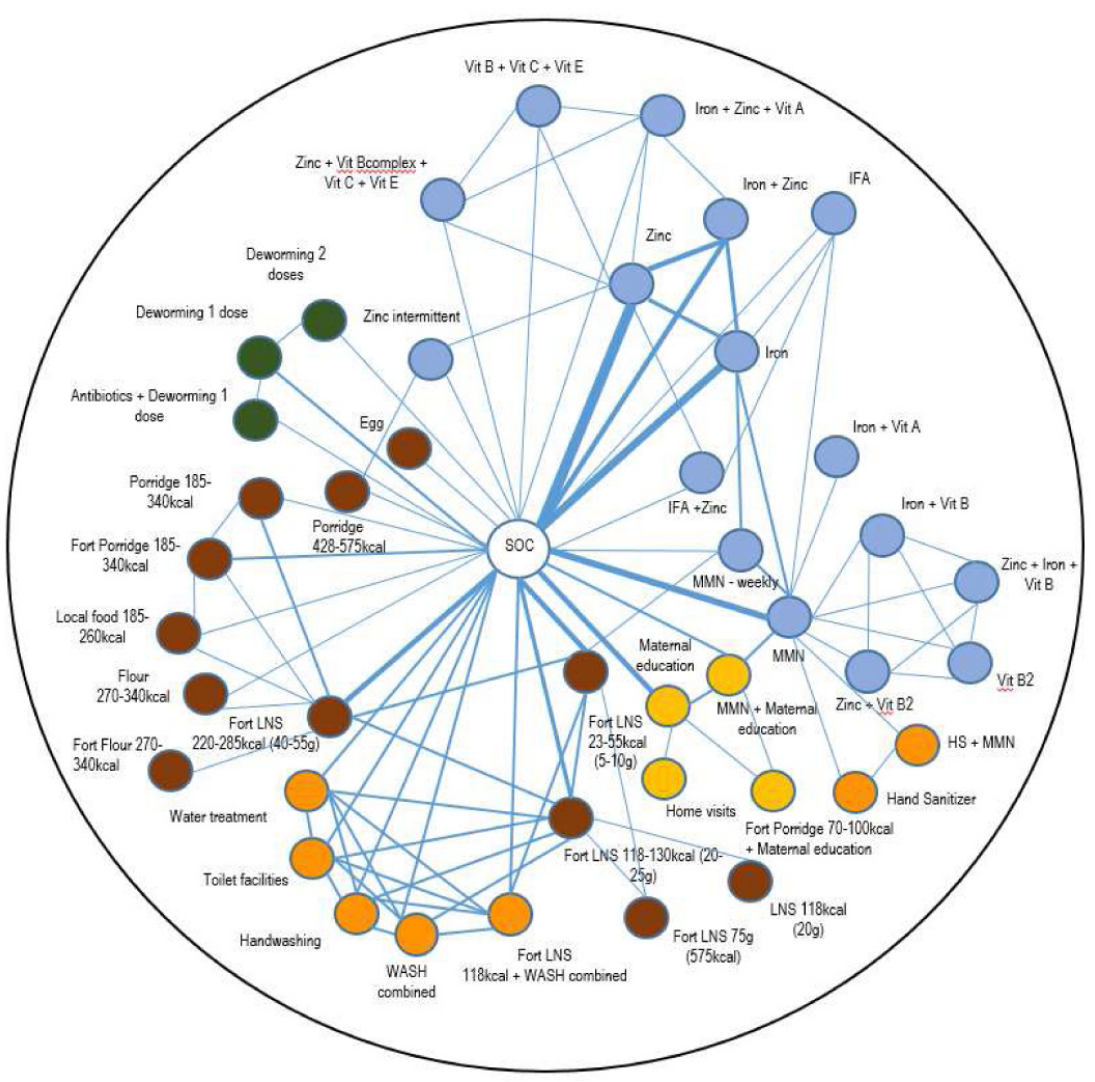
Figure 2. Overall network of the comparisons between interventions for children aged 6 to 24 months. Each node (circle) represents an intervention, each line represents a direct comparison between interventions, with the lines with width representing the number of trials with the direct comparisons in question (i.e. thicker width represents a direct comparison with larger numbers of trials). The different intervention domains are indicated with the following colors: blue for micronutrient supplements; brown for food supplements; yellow for education and counseling interventions; green for deworming interventions; and orange for WASH interventions. Vit. vitamin; IFA, iron and folic acid; LNS, lipid-based nutrient supplements; Fort, fortification; MMN, multiple micronutrients; HS, hand